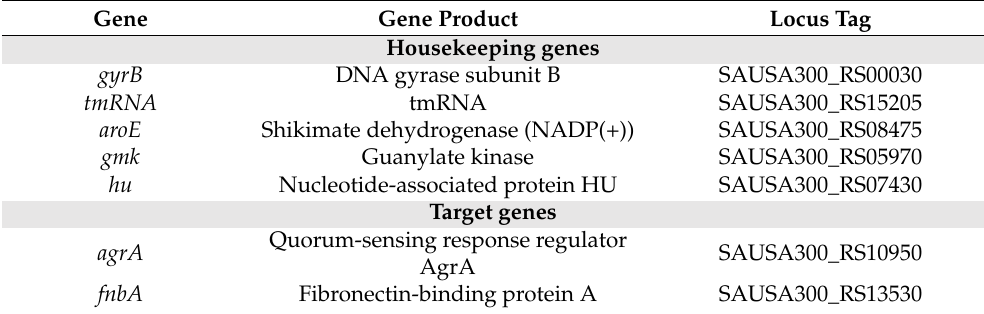
Table 3. Overview of investigated bacterial housekeeping genes and target genes.